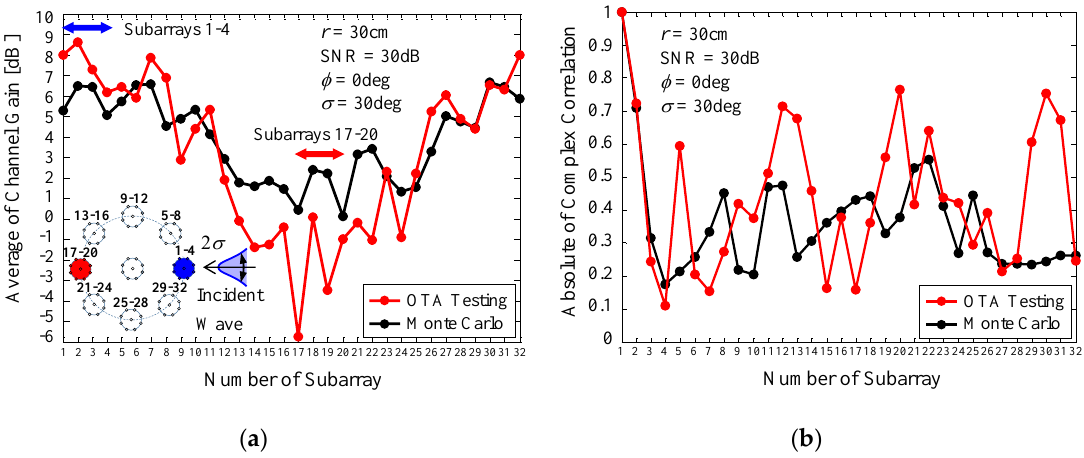
Figure 24. Channel gain and correlation of a 32 × 32 MIMO array measured by OTA testing. ( a ) Channel gain. ( b ) Correlation.